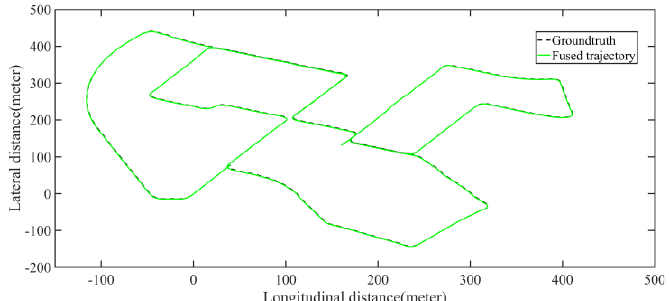
Figure 8. LiDAR l ocalization based on prior KITTI point cloud map; the white points in the figure are the point cloud map built by the offline mapping process, the red line is the trajectory of LiDAR matching results, the orange line is groundtruth, and the blue line is the fused trajectory.